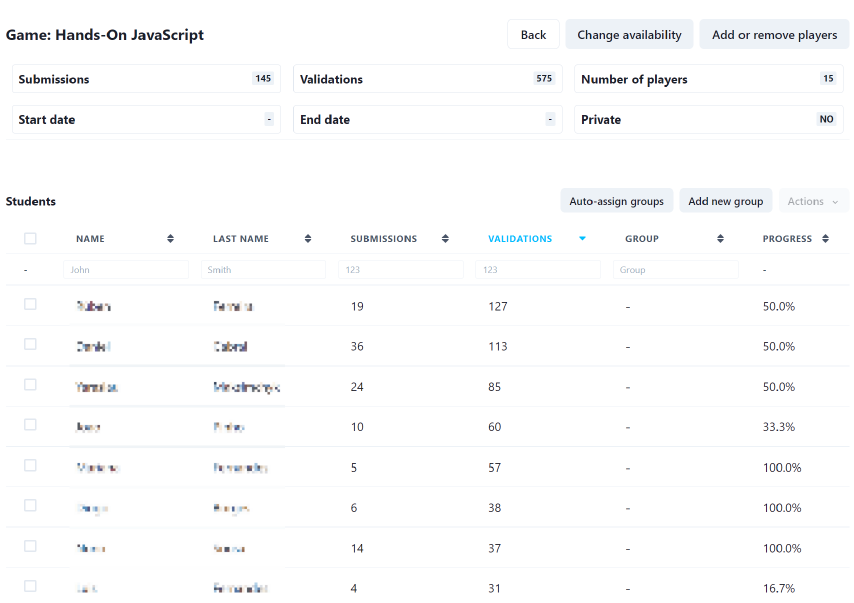
Figure 6. Exemplary screenshot of the FGPE PLE Teacher UI: game